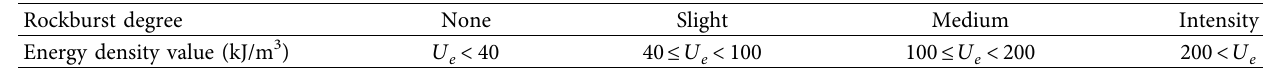
Table 3: Grading value of rockburst